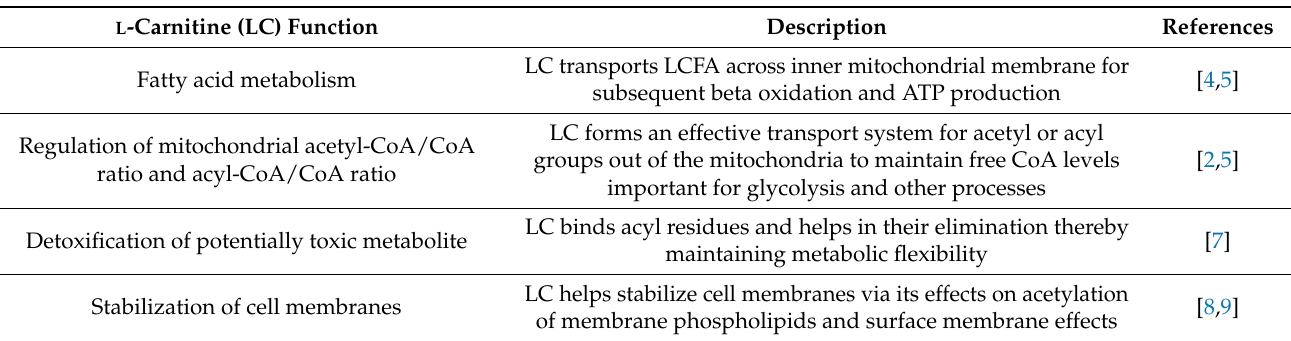
Table 1. Major L -carnitine functions in cellular Table 1. Major L-carnitine functions in cellular metabolism.